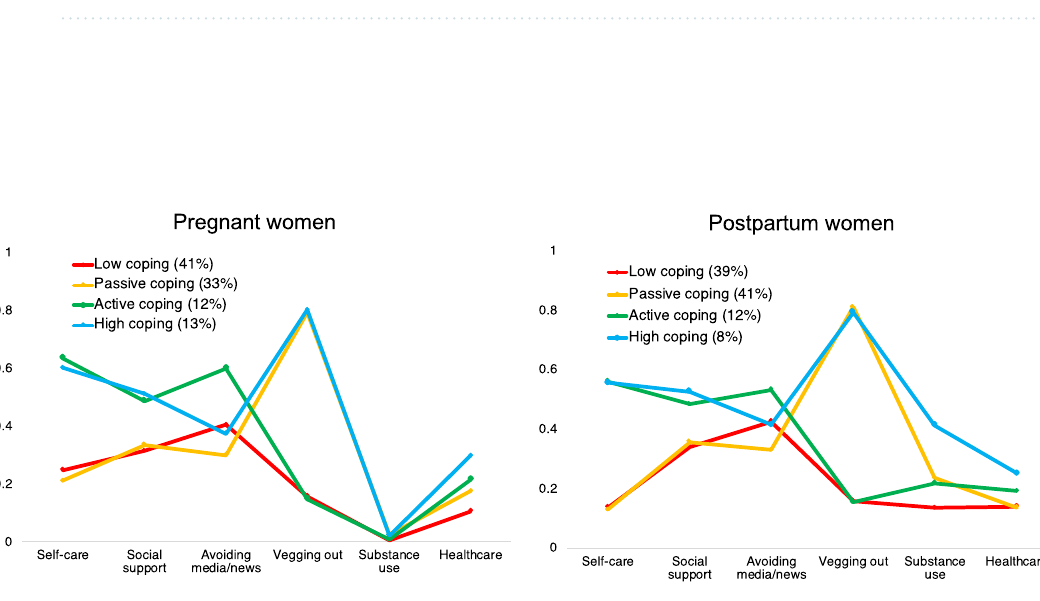
Figure 3. Estimated means for the 6 coping strategies across all profiles for both pregnant women and postpartum women. Differing levels of vegging out, self-care, and social support were key factors that most strongly differentiated profiles in both pregnant and postpartum